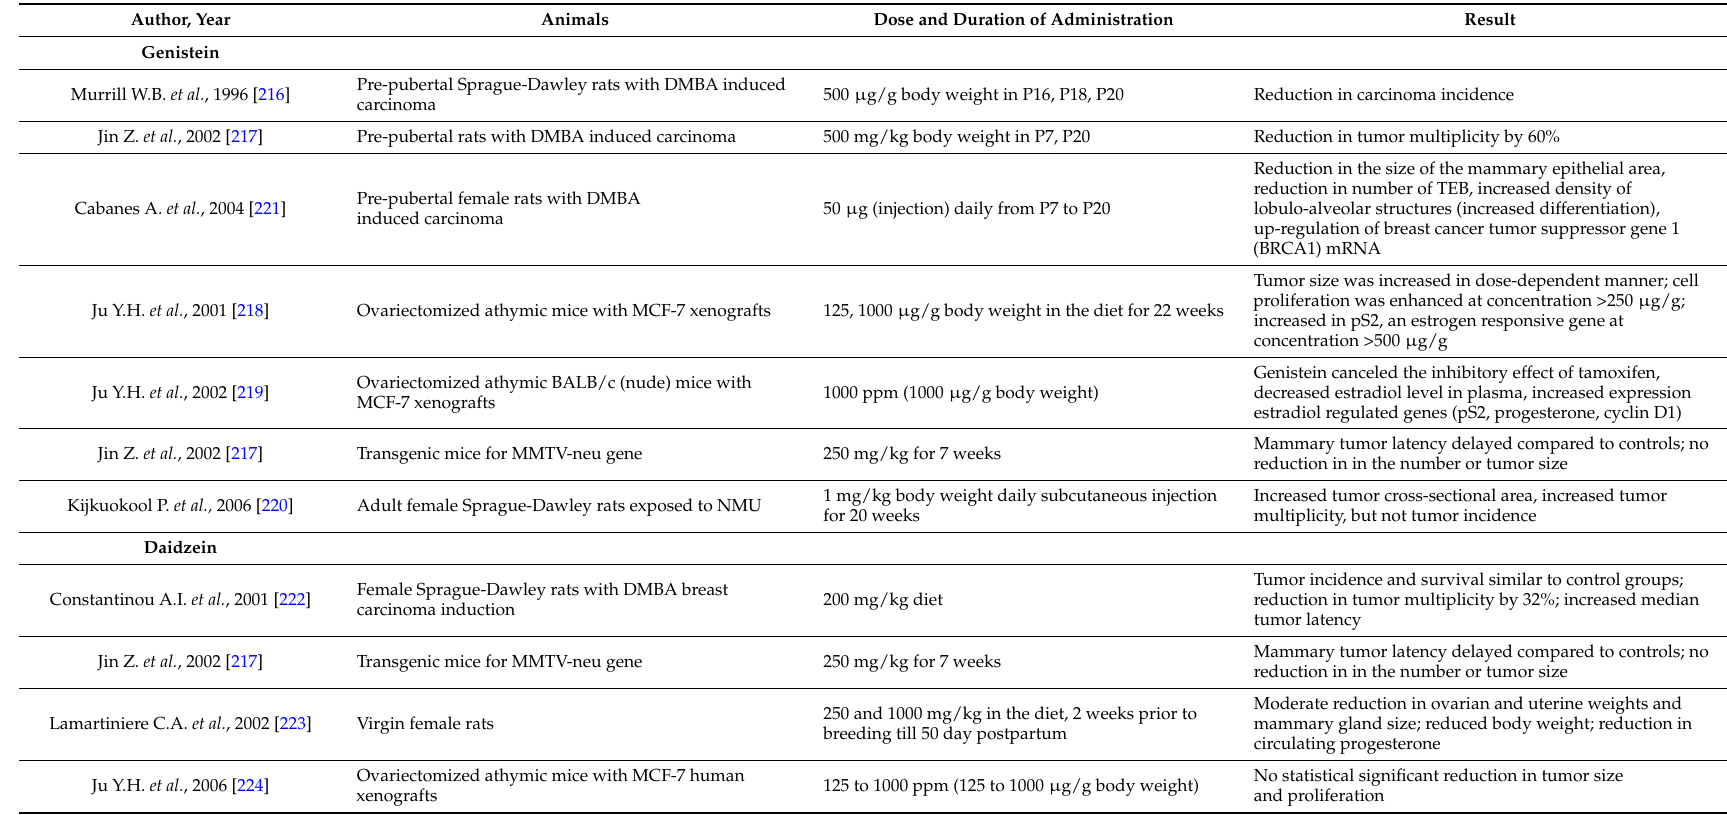
Table 3. Summary of in vivo experiments: breast cancer and